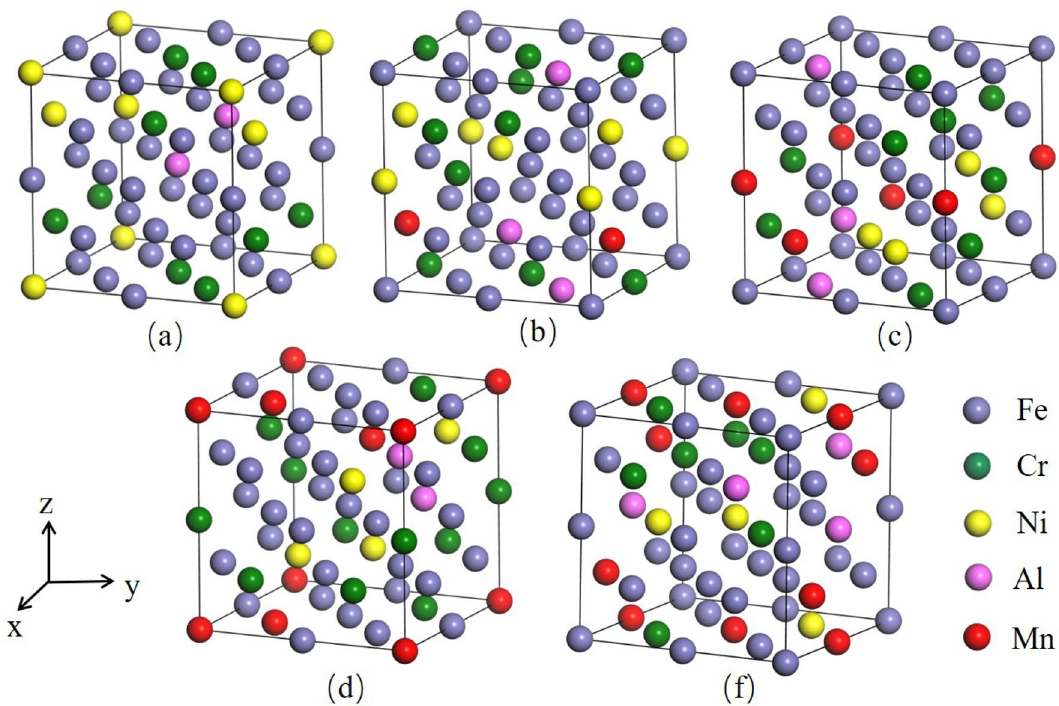
Figure 1. Schematic diagram of the calculation model: ( a ) Fe 22 –Cr 5 –Ni 3 –Al 2 ( b ) Fe 21 –Cr 5 –Ni 3 –Al 2 –Mn ( c )